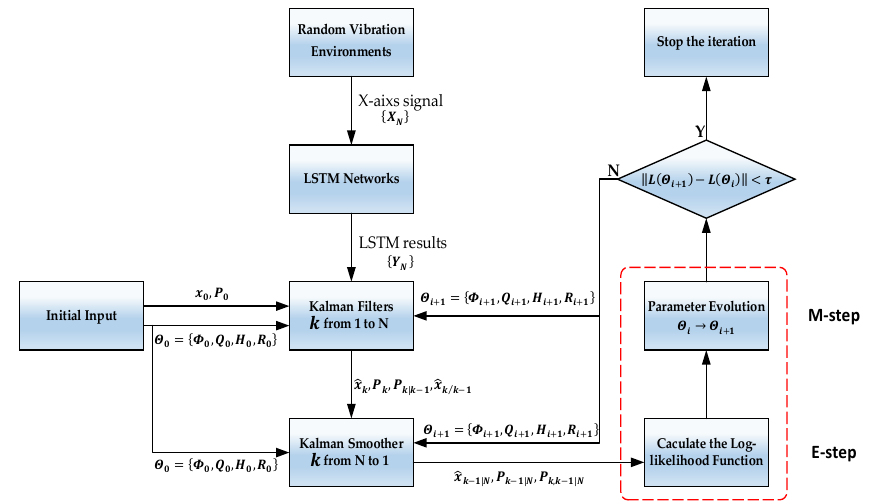
Figure 2. An illustration of this paper’s proposed method.